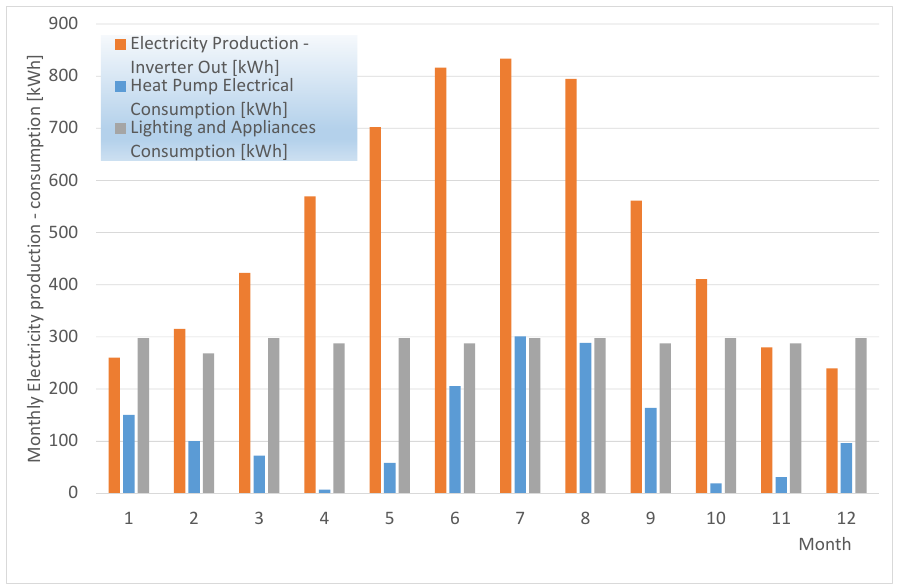
Figure 7. Monthly electricity production and consumption during one full year (reference PV installation size of 16 panels).